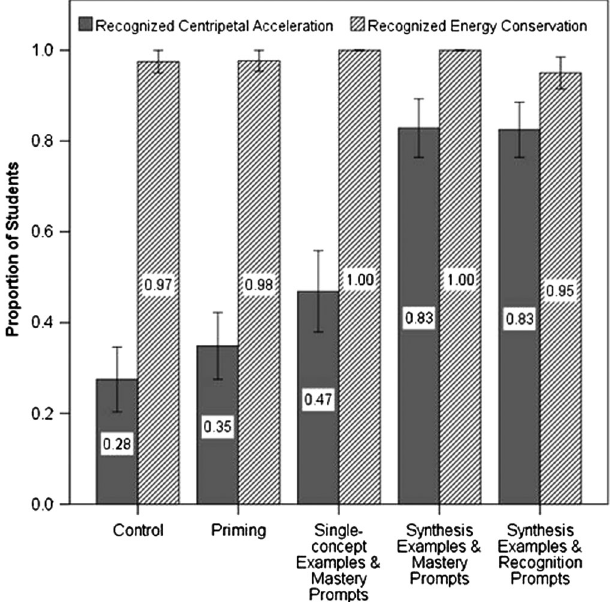
FIG. 4. Proportion of students in each condition demonstrating recognition of centripetal acceleration and energy conservation. Error bars are standard